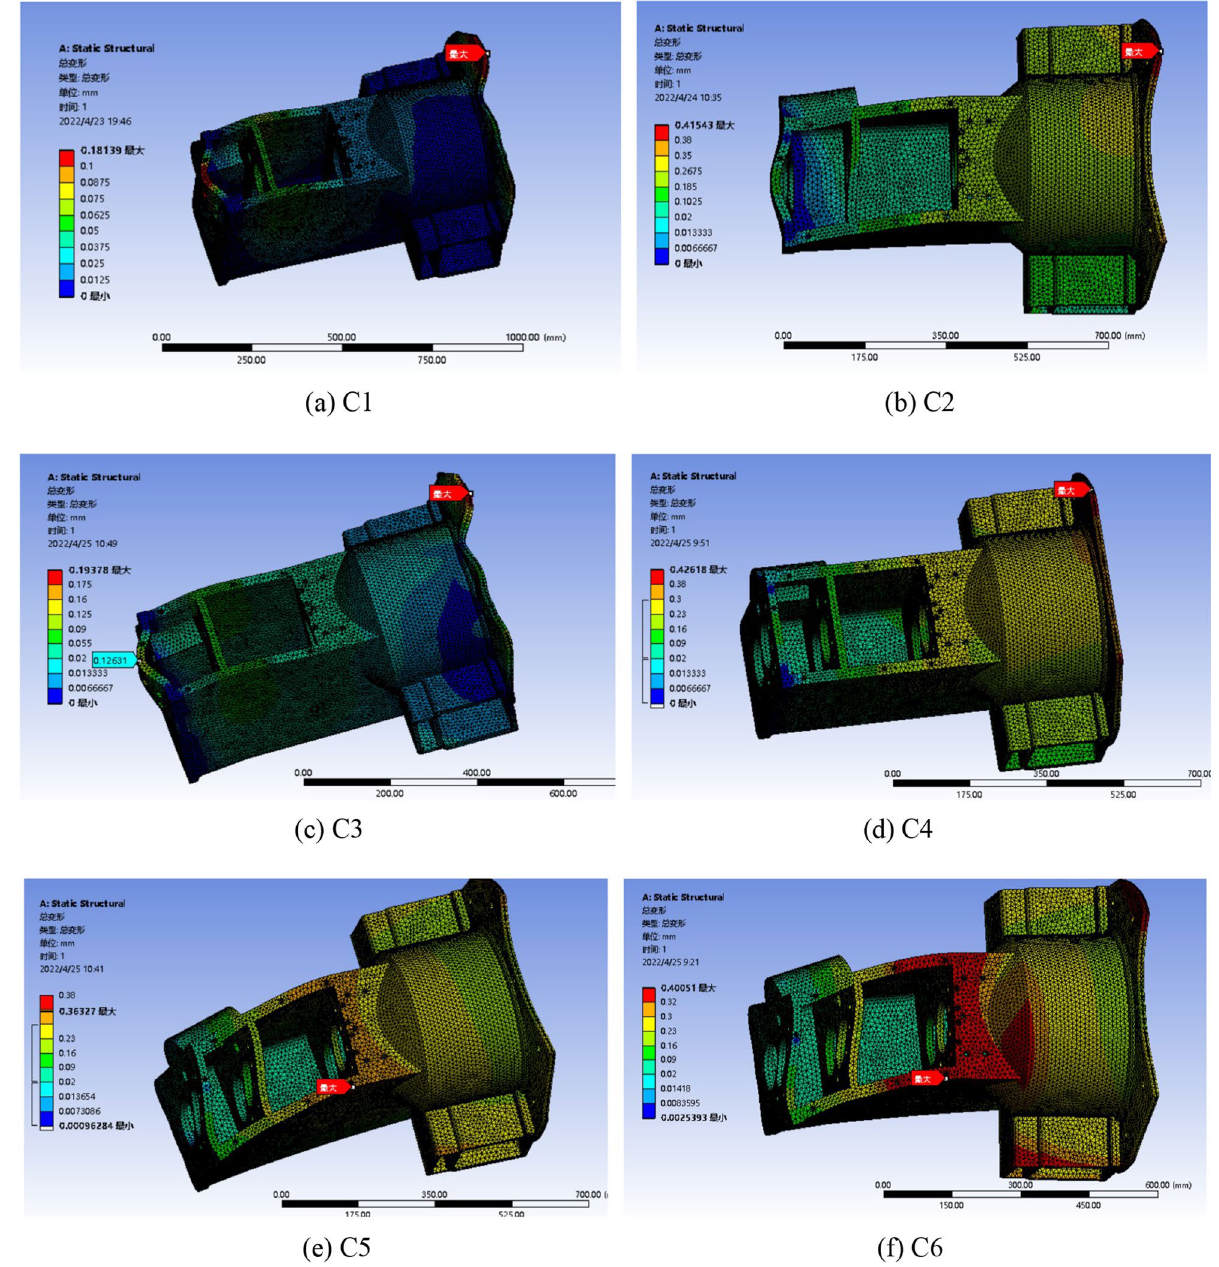
Figure 8. Deformation nephogram of the box under different working